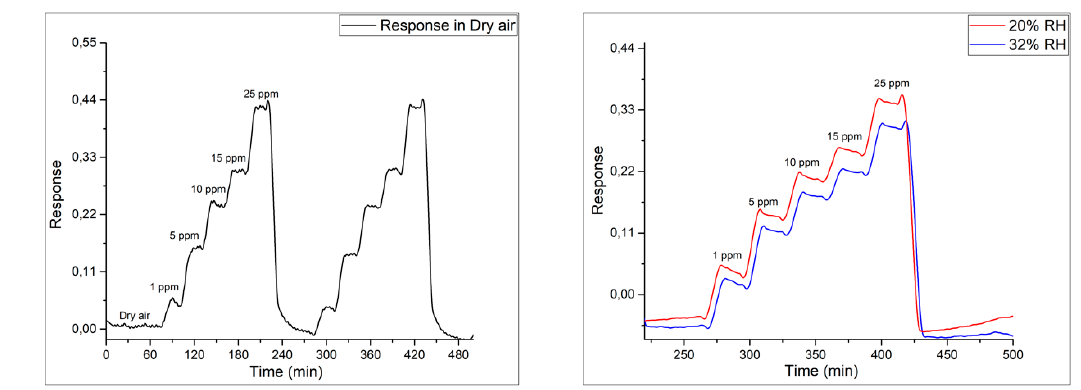
Figure 2. Response of TiO 2 /SnO 2 to Ethanol in both dry air and in the presence of relative humidity (cid:3008) (cid:3282)(cid:3276)(cid:3294) (cid:2879)(cid:3008) (cid:3276)(cid:3284)(cid:3293) with 𝑅𝑒𝑠𝑝𝑜𝑛𝑠𝑒 (cid:3404) (cid:3008) (cid:3276)(cid:3284)(cid:3293)